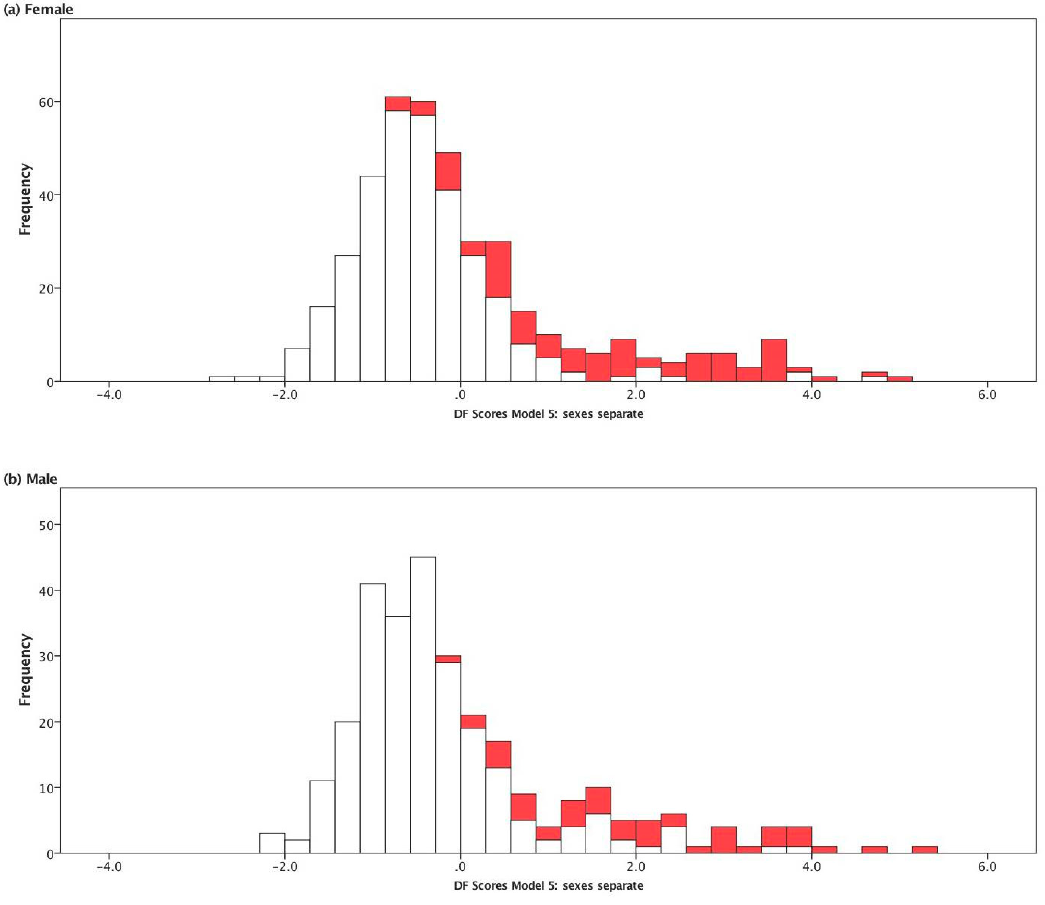
Figure 3. Histogram of scores from Model 5 discriminant functions analysis, for ( a ) females and ( b ) males. Solid bars: Type 2 diabetes mellitus (T2DM) participants; open bars: Non-T2DM participants.